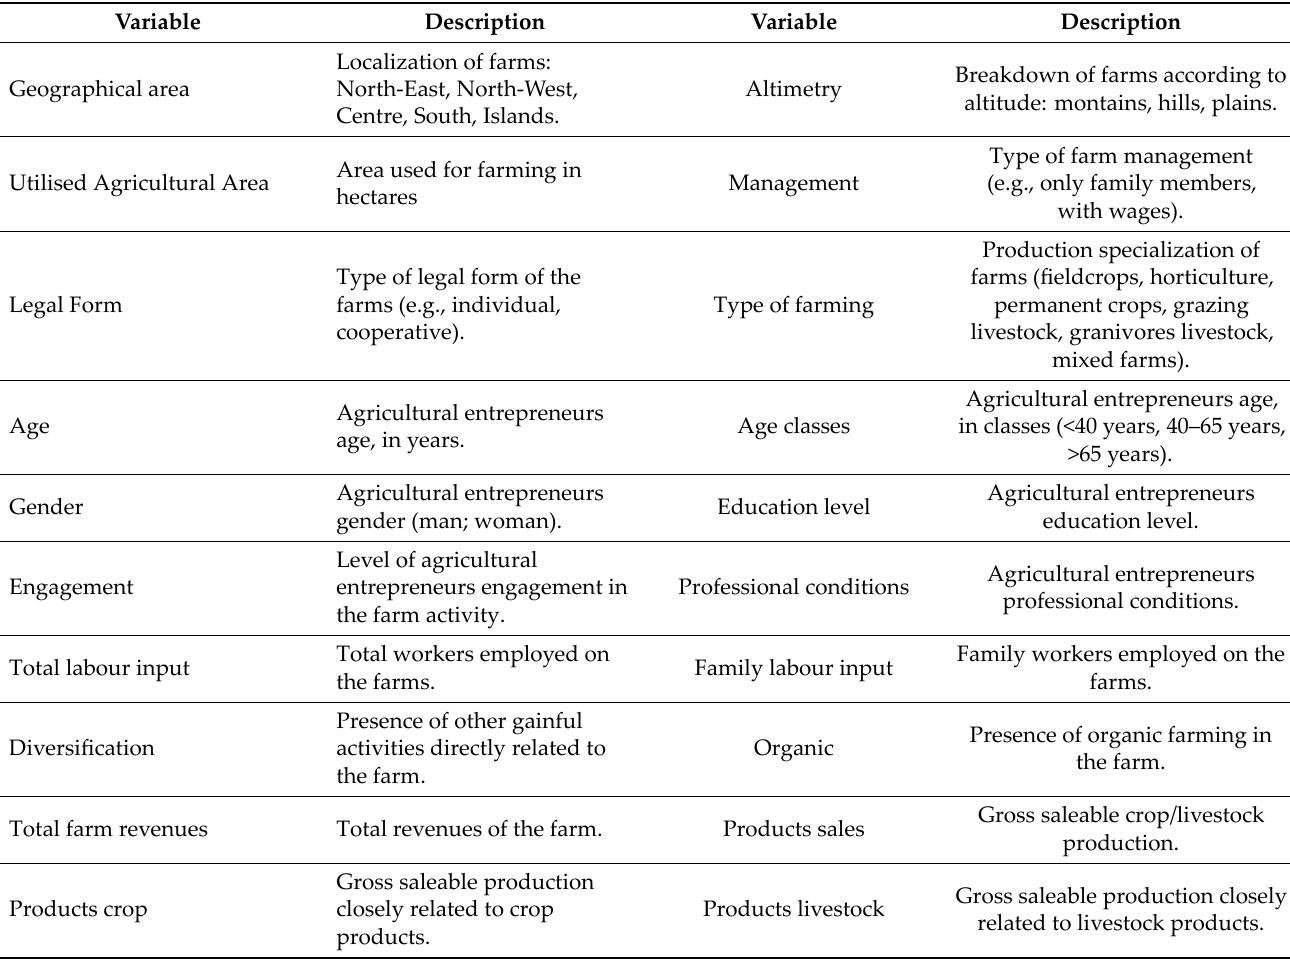
Table A3. Description of the variables used in the regression